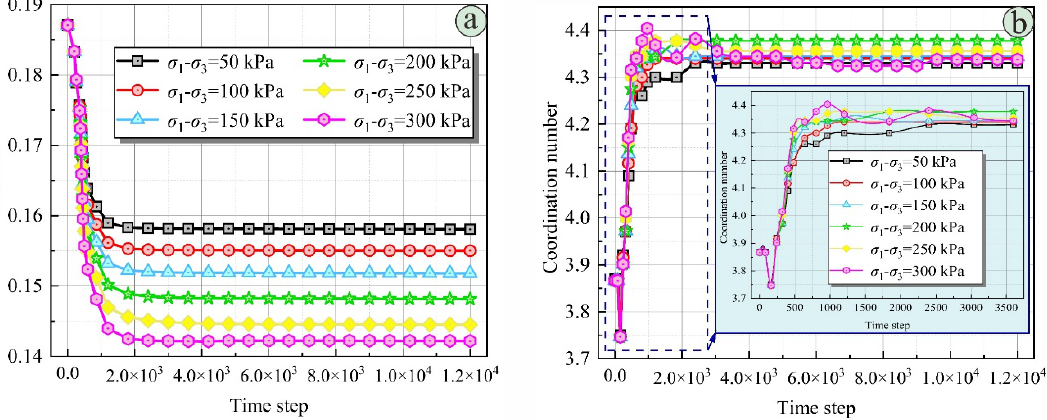
Figure 11. Variation of void ratio and coordination number with time step: ( a ) Void ratio; ( b ) Coordination number.